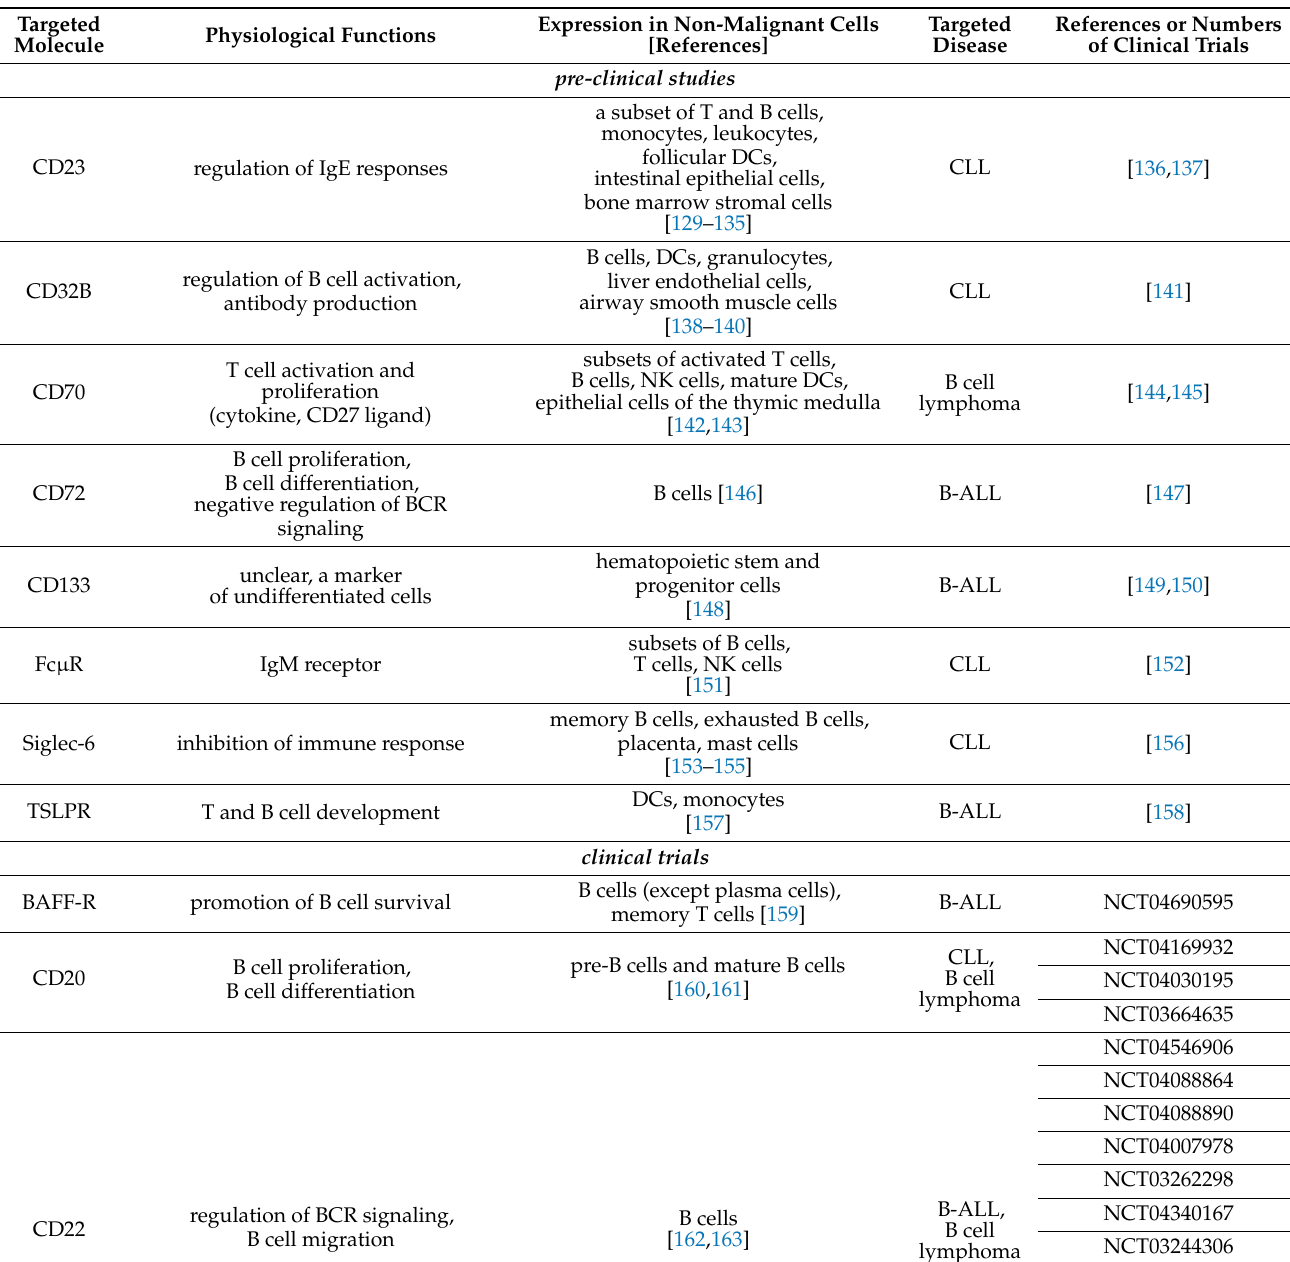
Table 2. Alternative targets for CAR-T therapy in B cell and plasma cell-derived malignancies (listed